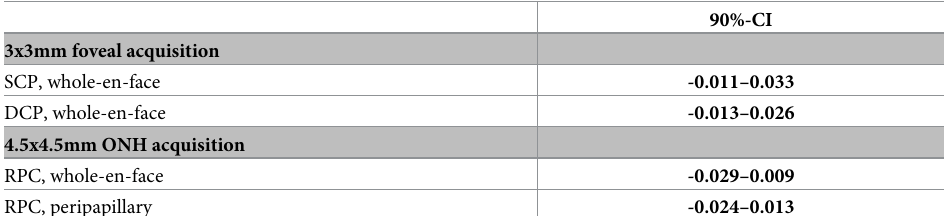
Table 3. Results for the 90%-confidence